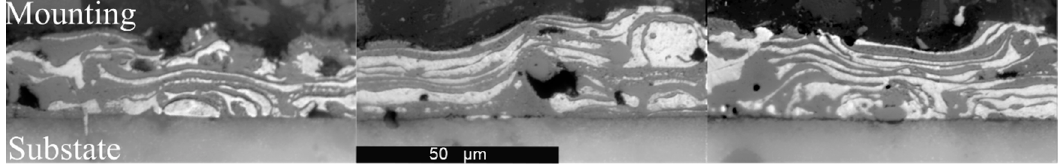
Figure 2. An optical microscopy image of the cross-section of the film at three positions along the element, showing the film inhomogeneity.